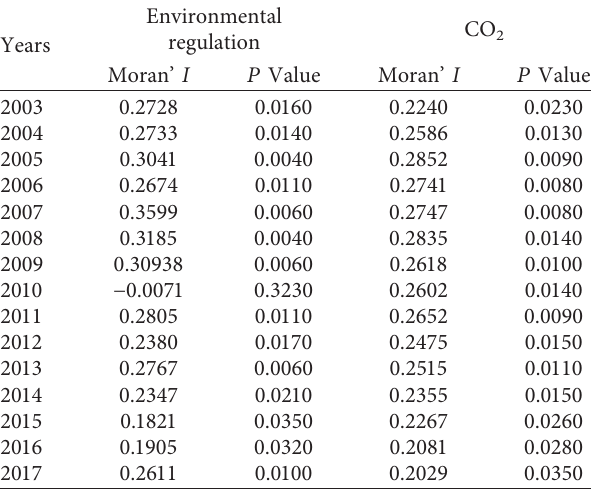
Table 2: Moran’s I values for environmental regulation and carbon